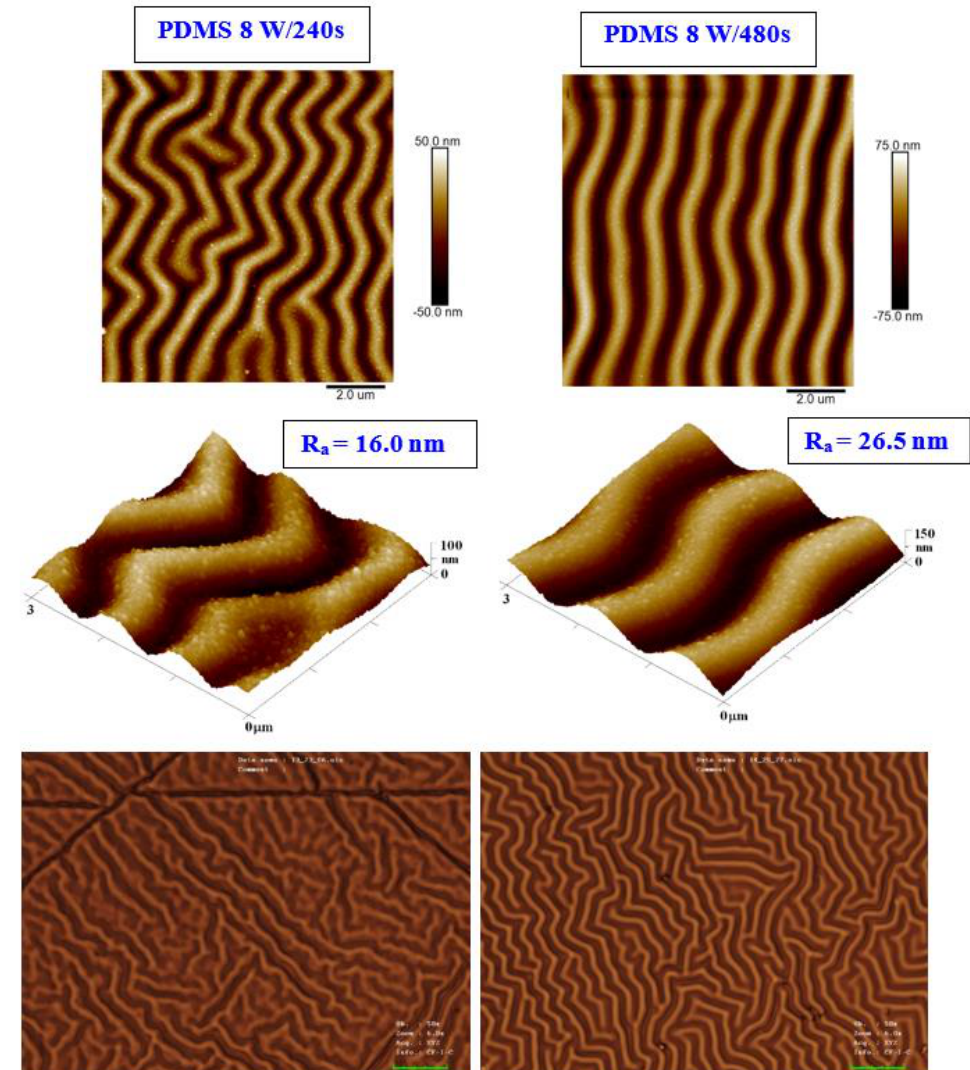
Figure 2. The surface morphology of a PDMS foil was treated by plasma at 8 W for 240 and 480 s and subsequently heated for 1 h at 100 °C. The first line represents the 2D morphology of samples with an inspected area of 10 × 10 μm 2 ; the second line represents a 3D detail of the sample images (3 × 3 μm 2 ). The bottom line represents laser confocal microscopy scans of the same samples with an inspected area of 43 × 32 μm 2 .